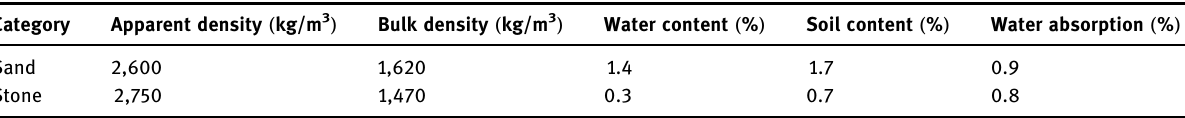
Table 3: Physical properties of natural aggregate Category